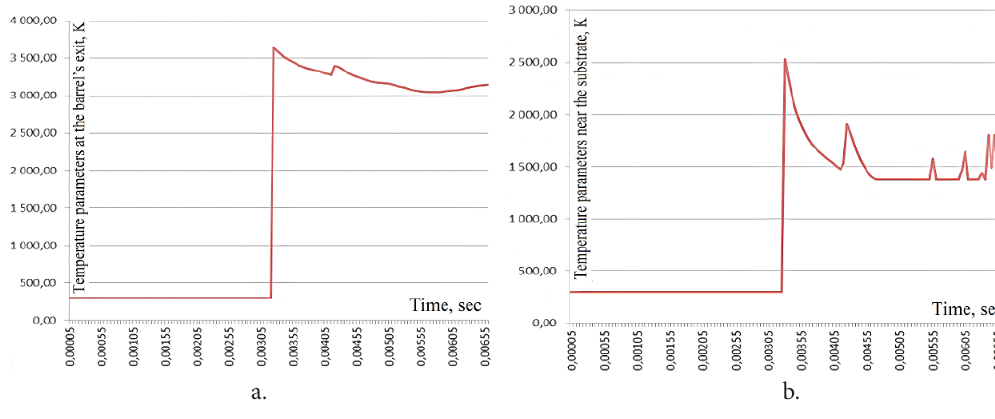
Figure 2. Carrier gas temperature parameters: a – at the barrel’s exit of the D-gun; b – near the substrate